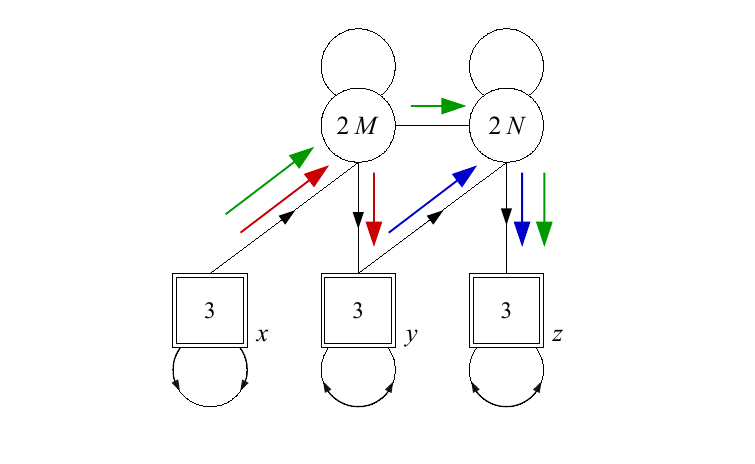
Figure 9 . Schematic representation of how the gauge invariant operators listed in table 6 are constructed. For example operators D (1) V (1) are indicated in red, D (2) V (2) in blue and D (1) QV (2) in